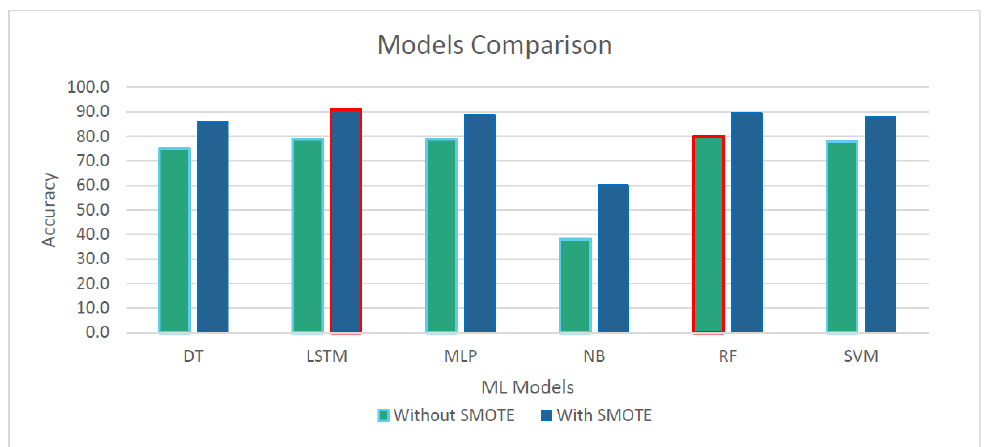
Figure 11. Exp2 Models Comparison.